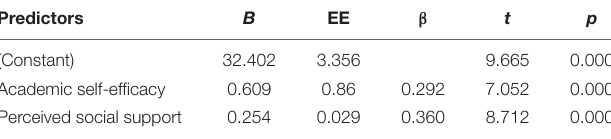
TABLE 4 | Predictors of stress-coping strategies in university